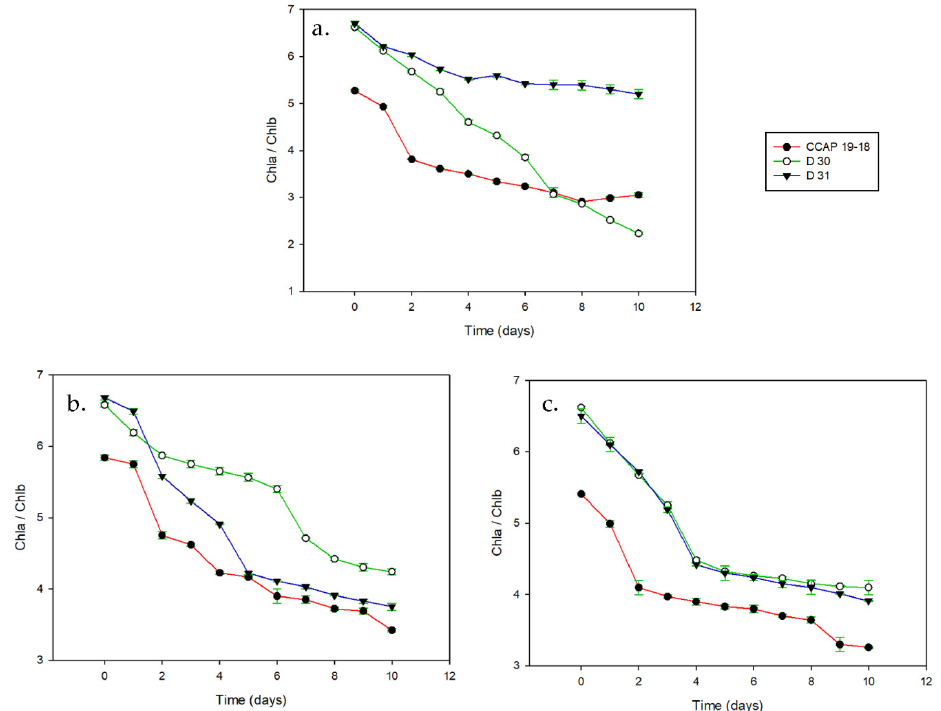
Figure 3. Daily changes in the chlorophyll-a/chlorophyll-b ratio (Chl a /Chl b ) of the studied strains cultivated in different conditions: ( a ) standard conditions, ( b ) nitrogen deprivation and ( c ) salinity stress (SE, n = 3).